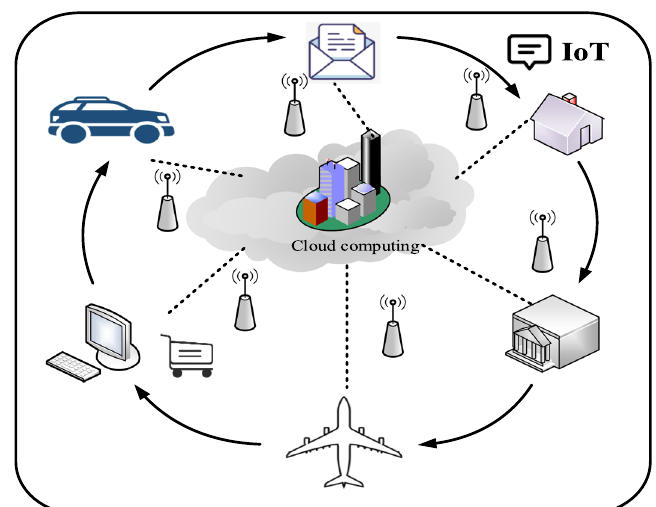
Fig. 1 Smart tourism system using IoT